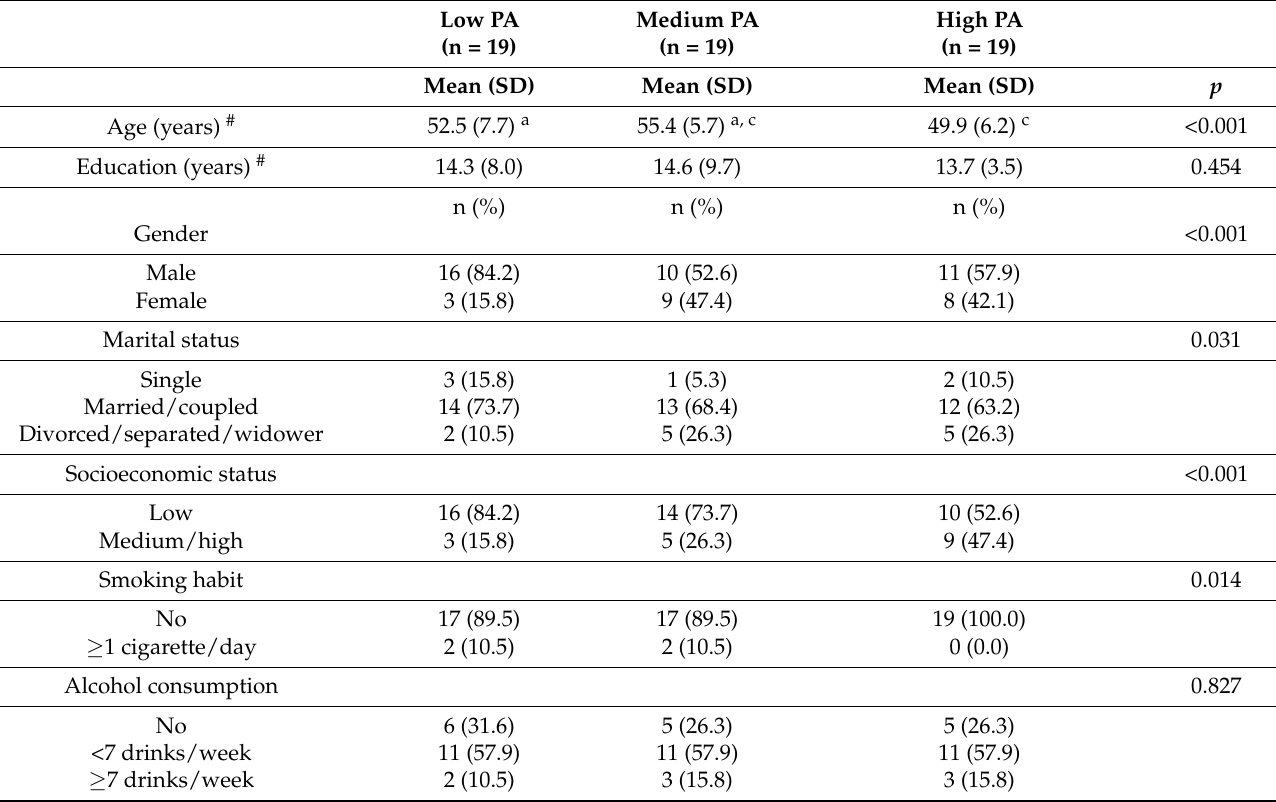
Table 1. Baseline sociodemographic characteristics of study